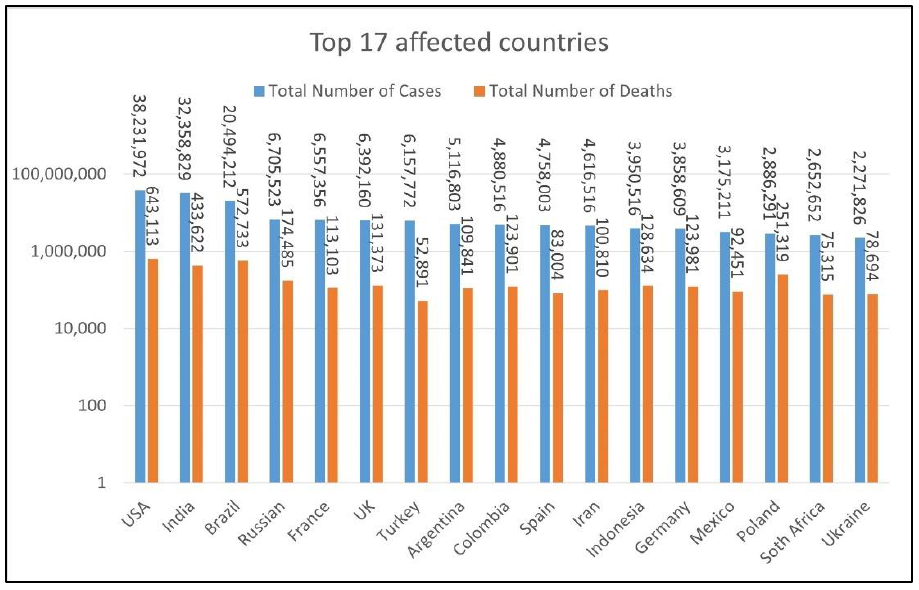
Figure 3. Top 17 most affected countries by COVID-19.